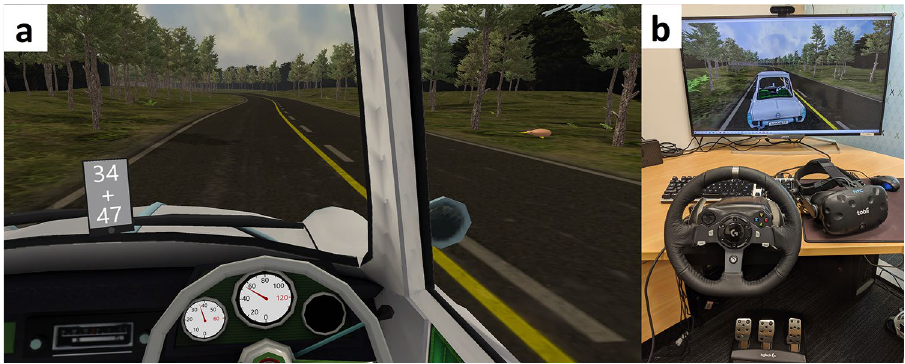
Figure 1. ( a ) The view from the driver’s seat of the car, showing the cellphone in the windscreen position, which was displaying an addition problem that participants were tasked with solving. Also visible through the driver’s window is a kiwi, which participants counted (as an external awareness task). ( b ) The virtual reality simulator setup showing the steering wheel, pedals, and VR headset. The position of the virtual car seat, and the real-world position of the chair, steering wheel and pedals could be adjusted so that real-world proprioception felt congruous with the visual positioning of the virtual wheel. The monitor displayed real-time driving performance and gaze information to the investigators (not visible to the